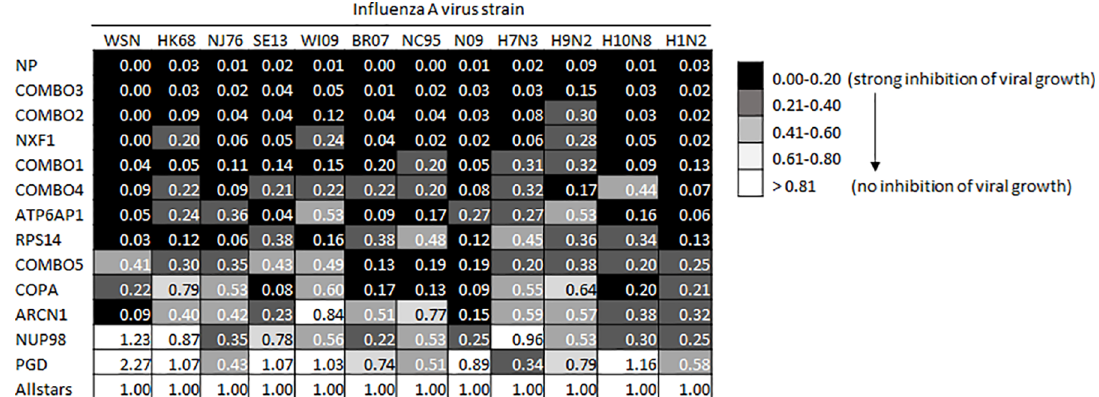
Fig 5. Inhibition of diverse influenza A virus in siRNA treated NHBE cells. The siRNA treatments listed on the left column were evaluated against each of twelve influenza strains noted across the top. Each combination was tested in triplicate and normalized to Allstars nontargeting siRNA. Relative mean viral growth is reported; 1.00 denotes no change relative to non-targeting siRNA, 0.50 denotes a 50% decrease in viral growth, and 0.00 denotes complete inhibition of viral growth.